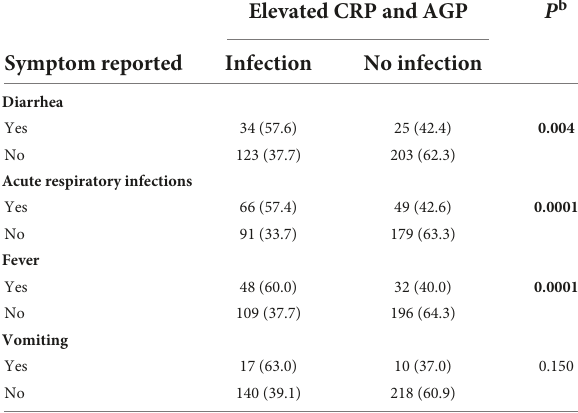
TABLE 3 Differences in infection as indicated by acute phase proteins (CRP and AGP) vs. maternal recalls of symptoms in the past 14 days